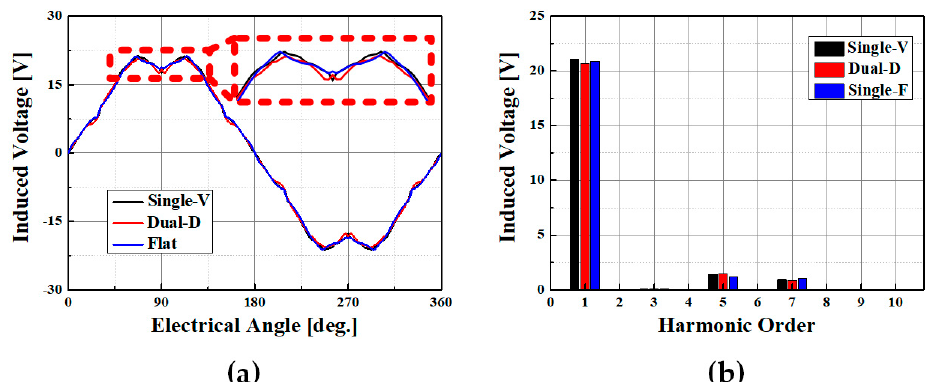
Figure 3. ( a ) Comparison of induced voltage of three different types of rotor shape at 1000 rpm without load. ( b ) Comparison of induced voltage of fast Fourier transform (FFT).